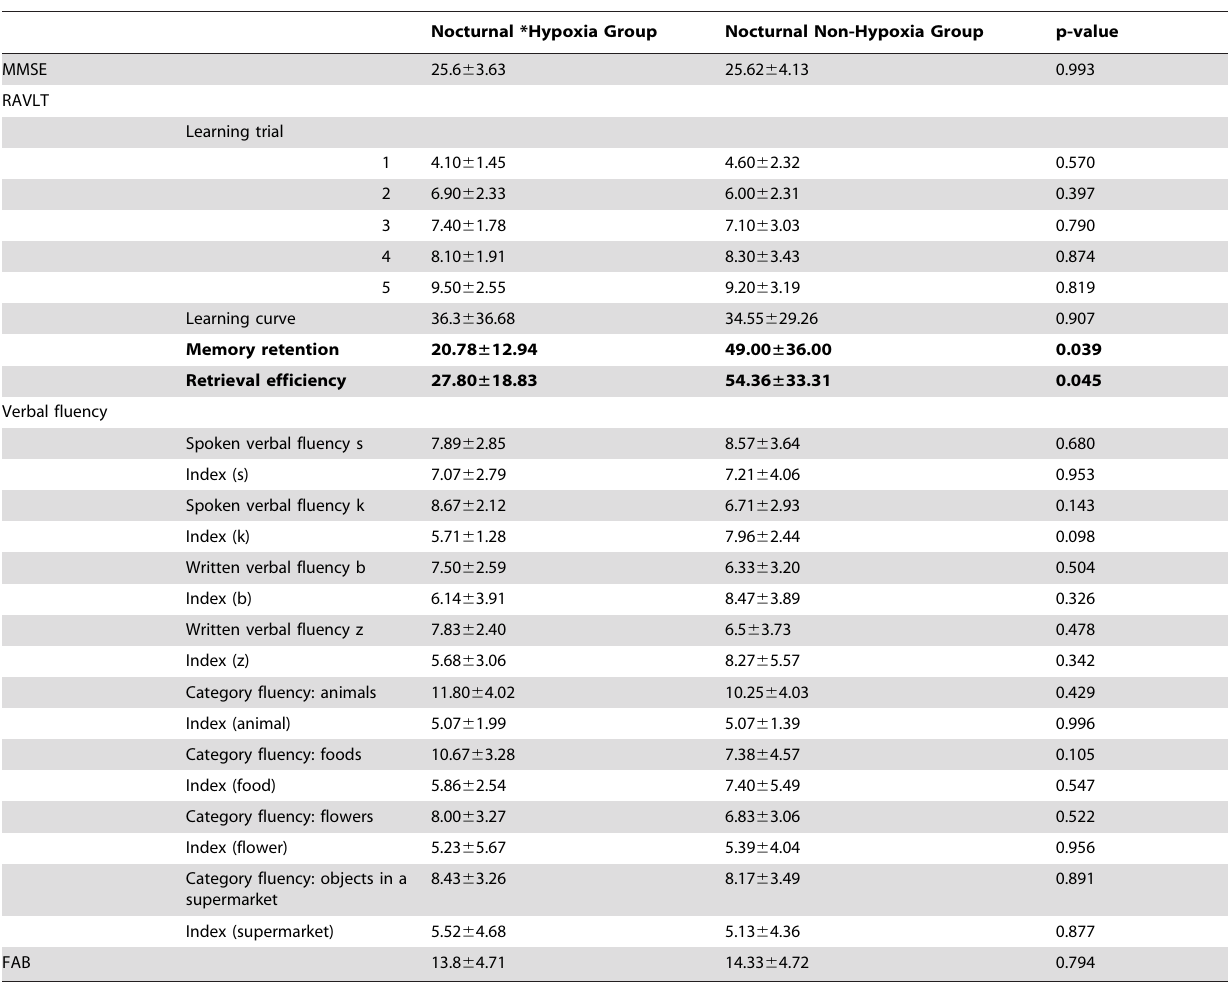
Table 2. Neuropsychologic characteristics of the patients with